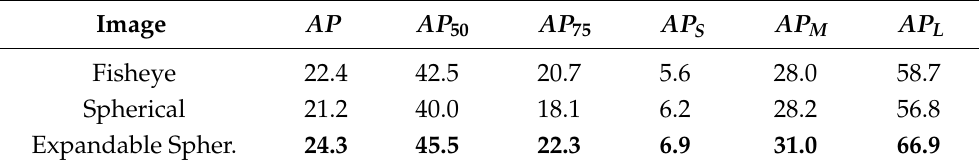
Table 5. Accuracy of different projections of YOLOv3-SPP model on Fisheye-CityScape.